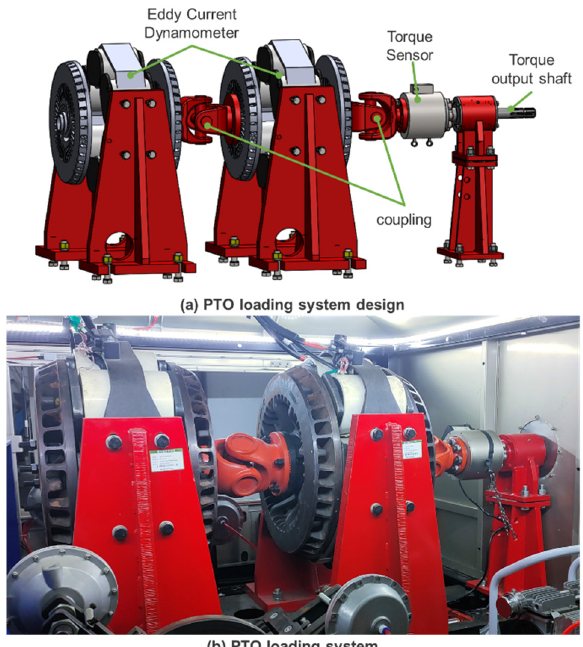
Figure 5. The structure of PTO loading